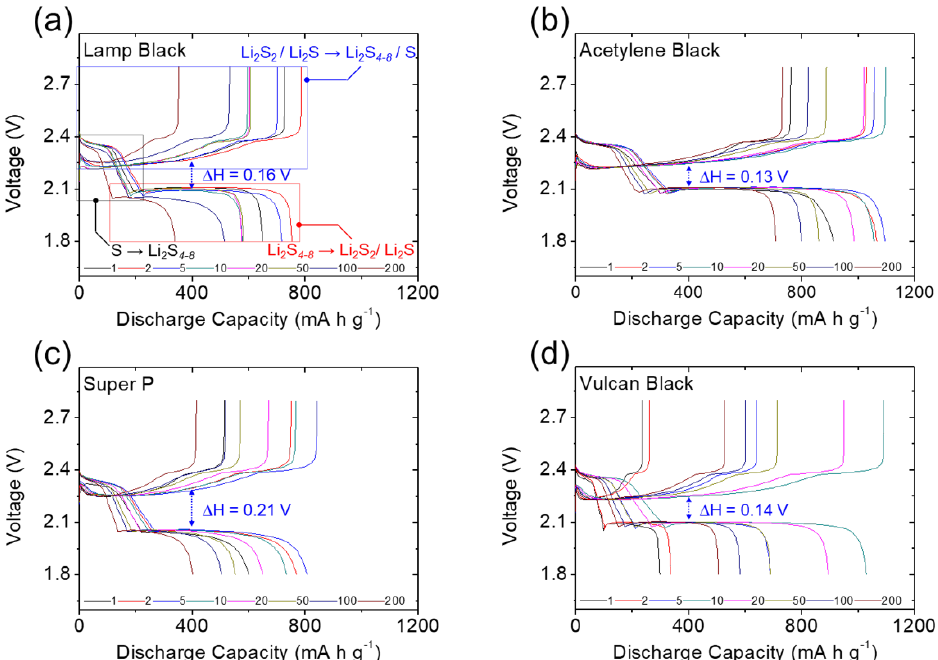
Figure 3. Electrochemical analysis: galvanostatic charge/discharge voltage profiles of the high-loading sulfur cathode in the lean-electrolyte cells with different carbon coating modules of ( a ) lamp black, ( b ) acetylene black, ( c ) Super P, and ( d ) Vulcan black.